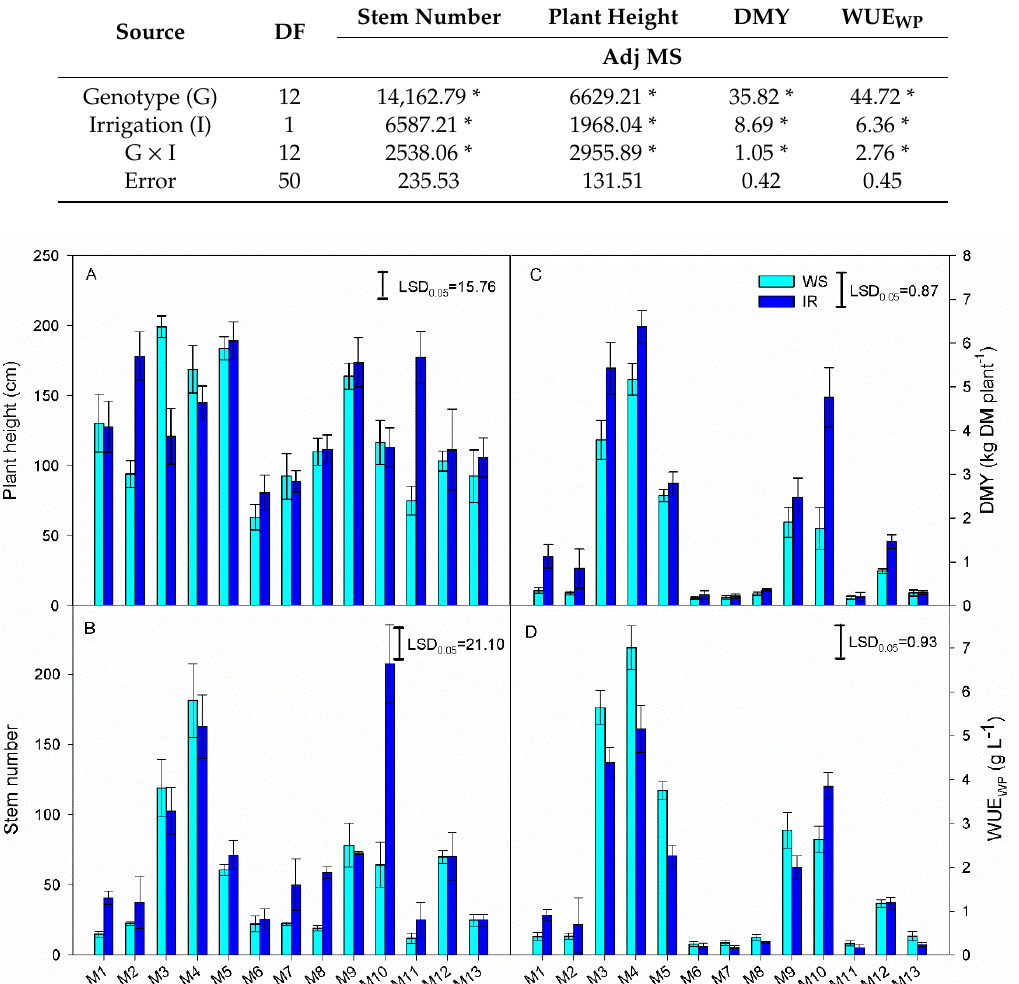
Figure 2. Plant height (cm), stem number, biomass dry matter yield (DMY, kg DM plant − 1 ) and whole plant water use efficiency (WUE WP , g L − 1 ) of Miscanthus genotypes (M1— Mxg , M2— M. sacchariflorus